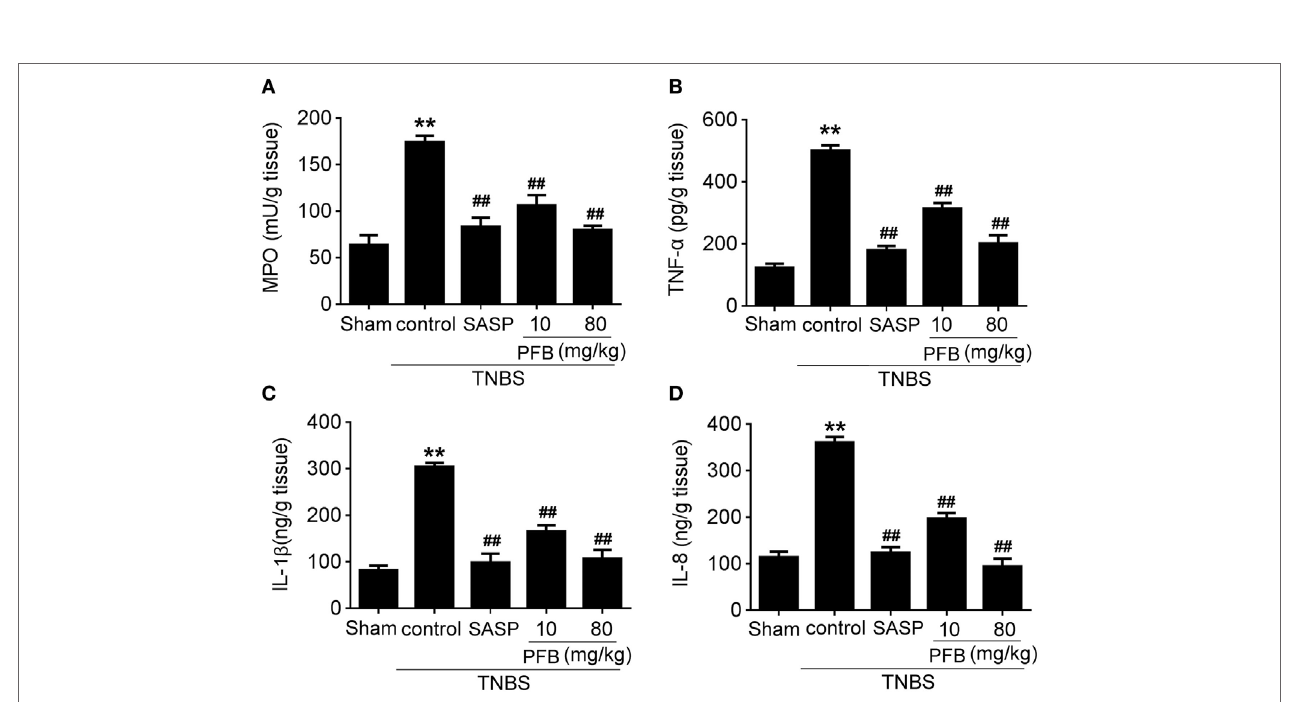
FigUre 3 | Purified fruit bromelain (PFB) attenuated neutrophil infiltration and cytokine profiles. Effects of PFB on (a) myeloperoxidase (MPO), (B) TNF- α , (c) IL-1 β , and (D) IL-8 in rat colon tissue determined by enzyme-linked immunosorbent assay. Data are expressed as the mean ± SD; ** P < 0.01 compared with sham group; ## P < 0.01 compared with TNBS control group ( n = 6 rats). SASP, sulfasalazine.